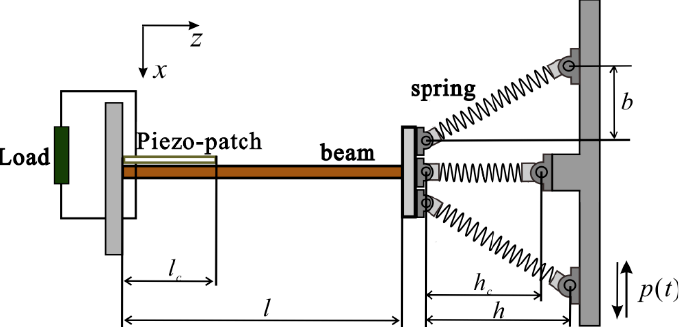
Figure 1. Schematic presentation of QEH.